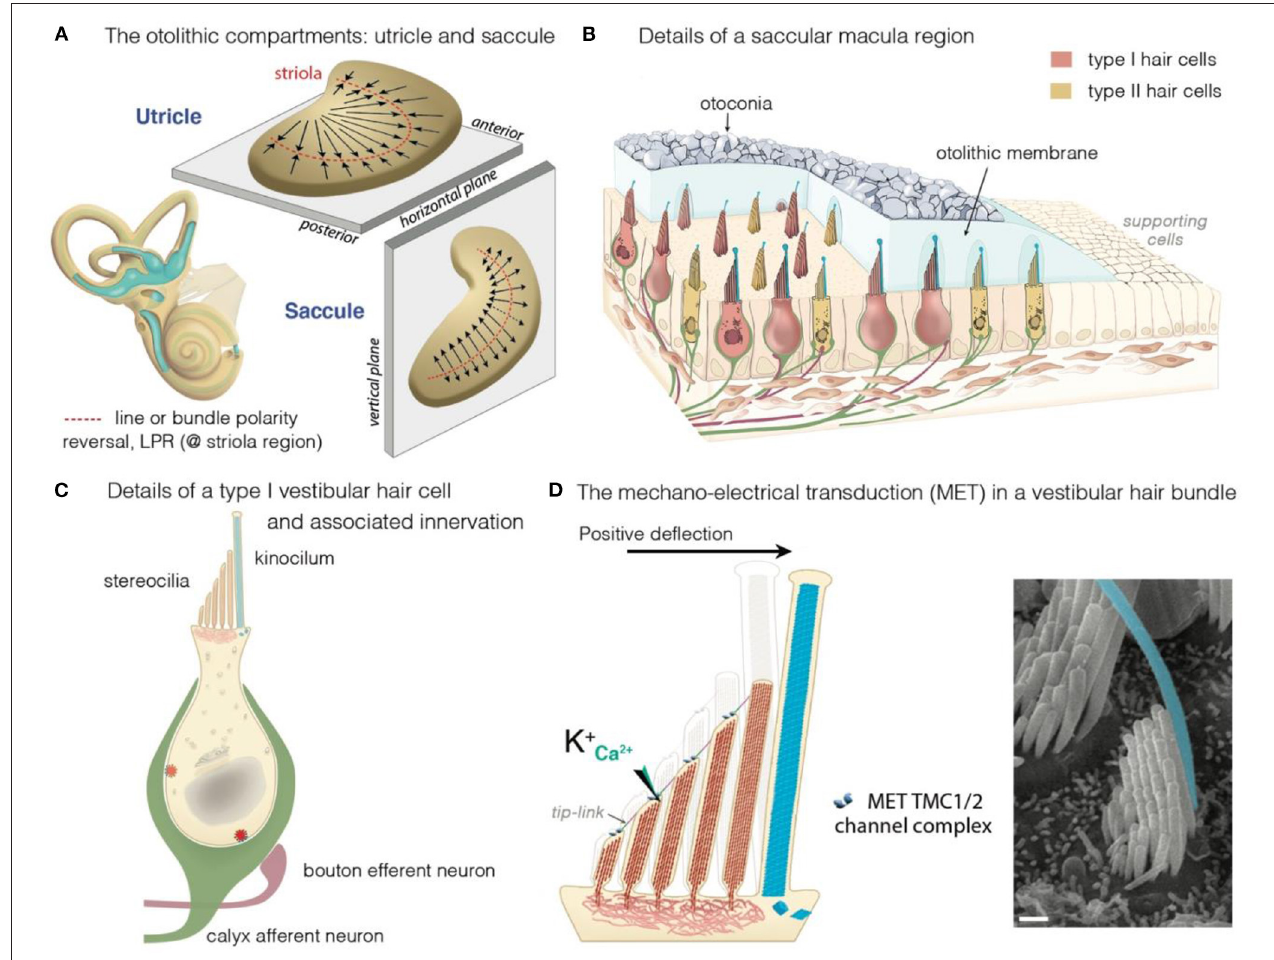
FIGURE 2 | The vestibular maculae, the hair cells and motion-induced mechano-electrical transduction. (A) Illustration of the morphological and the polarization of hair cells in the utricular and saccular maculae: the black arrows indicate the orientation of the hair bundles. In the utricle, hair cells are oriented with their stereociliary bundles pointing toward the line of polarity reversal (LPR, in red). In the saccule, the stereociliary bundles point away from the LPR. (B–D) Overview of a macular sensory region (B) , type I vestibular hair cells (VHCs) (C) , and the hair bundle (D) . (B) The VHCs extend their hair bundles into the overlying otolithic membrane; an extracellular matrix embedded with otoconia. The kinocilium is colored in cyan. Apart from difference in shape, type I and type II hair cells can also differ according to their innervation. Afferent (green) and efferent (dark purple red) are shown. (B,C) The VHCs are innervated by three types of afferent neurons: The calyx-only class of neurons makes contacts with type I hair cells, essentially in the striola region; dimorphic neurons contact both types of hair cells throughout the sensory epithelium, forming calyces with type I hair cells and boutons with type II hair cells; bouton-only afferents only contact type II hair cells located outside of the central striola region. (D) The basic transduction mechanism is the same in the auditory and vestibular hair cells: a mechanical stimulus bends the stereociliary bundle toward the kinocilium (artificially colored in cyan). The bundle deflection stretches the tip-link, causing an influx of K + and Ca 2 + ions into the transducing stereocilia. The ensuing change in cell membrane receptor potential leads to glutamate release, generating electrical signals in afferent neurons (green in B,C ) forming the VIIIth cranial nerve.